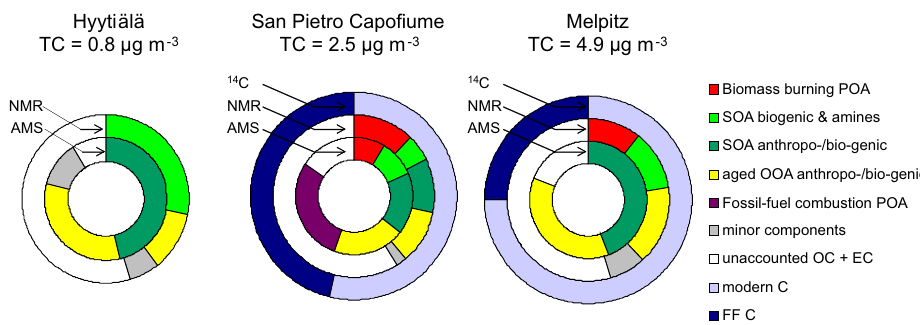
Fig. 6. Source apportionment for TC for Hyyti¨al¨a, SPC and Melpitz, based on the different methods used ( 14 C, H-NMR, AMS). “Biomass burning POA” are AMS “BBOA” and NMR factors correlated to biomass burning tracers (levoglucosan). “SOA biogenic & amines” in- clude AMS and NMR factors for amines, and the NMR factor for terpene SOA (Finessi et al., 2011b). “SOA anthropo-/bio-genic” include semivolatile organic compounds determined by AMS (SV-OOA) of unspecified anthropogenic or biogenic origin; or NMR factors for oxy- genated WSOC compounds of unspecified origin. “Aged OOA anthropo-/bio-genic” stand for low-volatility organic compounds determined by AMS (LV-OOA) of unspecified anthropogenic or biogenic origin, or NMR factors for oxygenated WSOC showing spectral profiles char- acteristic of humic-like substances (HULIS). “Fossil-fuel combustion POA” are approximated to AMS hydrocarbon-like compounds (HOA). All concentrations are calculated on a carbon basis. A circular arc of 360°refers to the average total carbon (TC = OC + EC) concentration at each